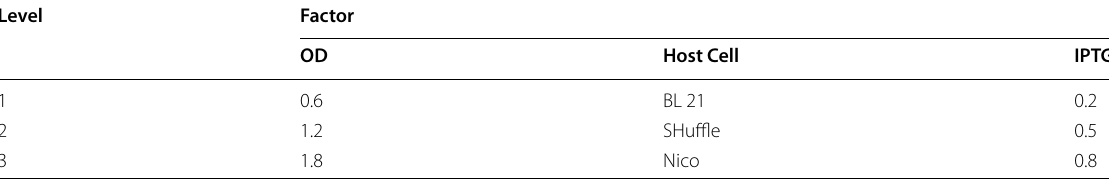
Table 1 Experiment design by RSM